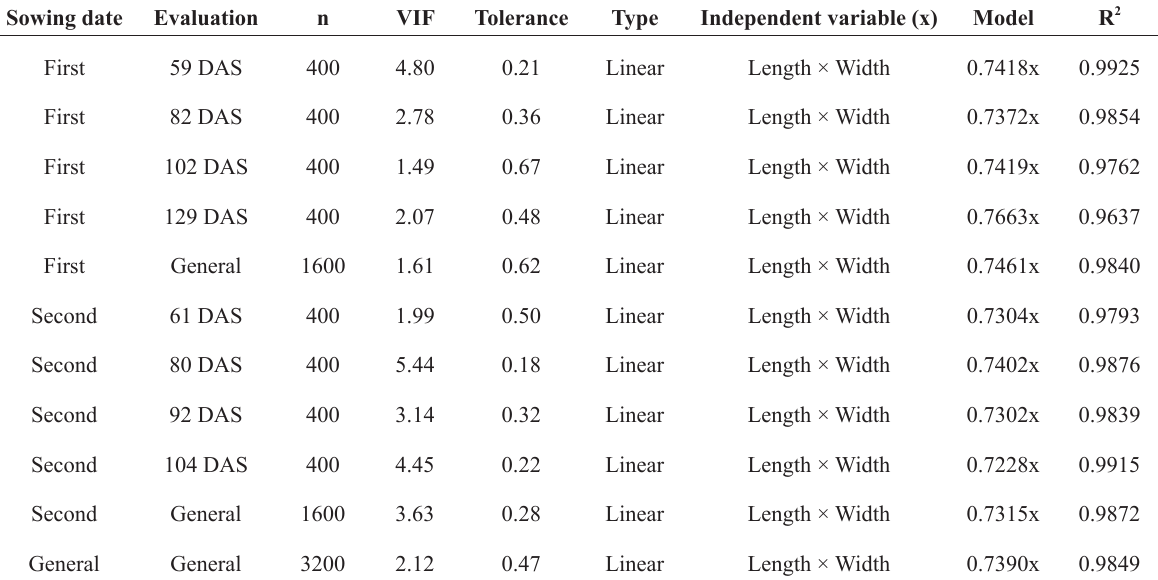
Number of leaves (n), variance inflation factor (VIF), tolerance, and linear models for the determination of the real leaf area (Y) using the length times width product as independent variables (x) - and the determination coefficient (R 2 ) of each model, based on sowing dates and ages (Days after sowing – DAS) of Crotalaria juncea . Validation of models is based on the indicators: linear coefficients (a), angular (b), linear correlation of Pearson (r) and determination (R 2 ), mean absolute error (MAE) and d index of Willmott (d), calculated based on observed and estimated 800 leaves of Crotalaria juncea leaf area on the 2014/15 harvest in Itaqui - RS - Brazil.